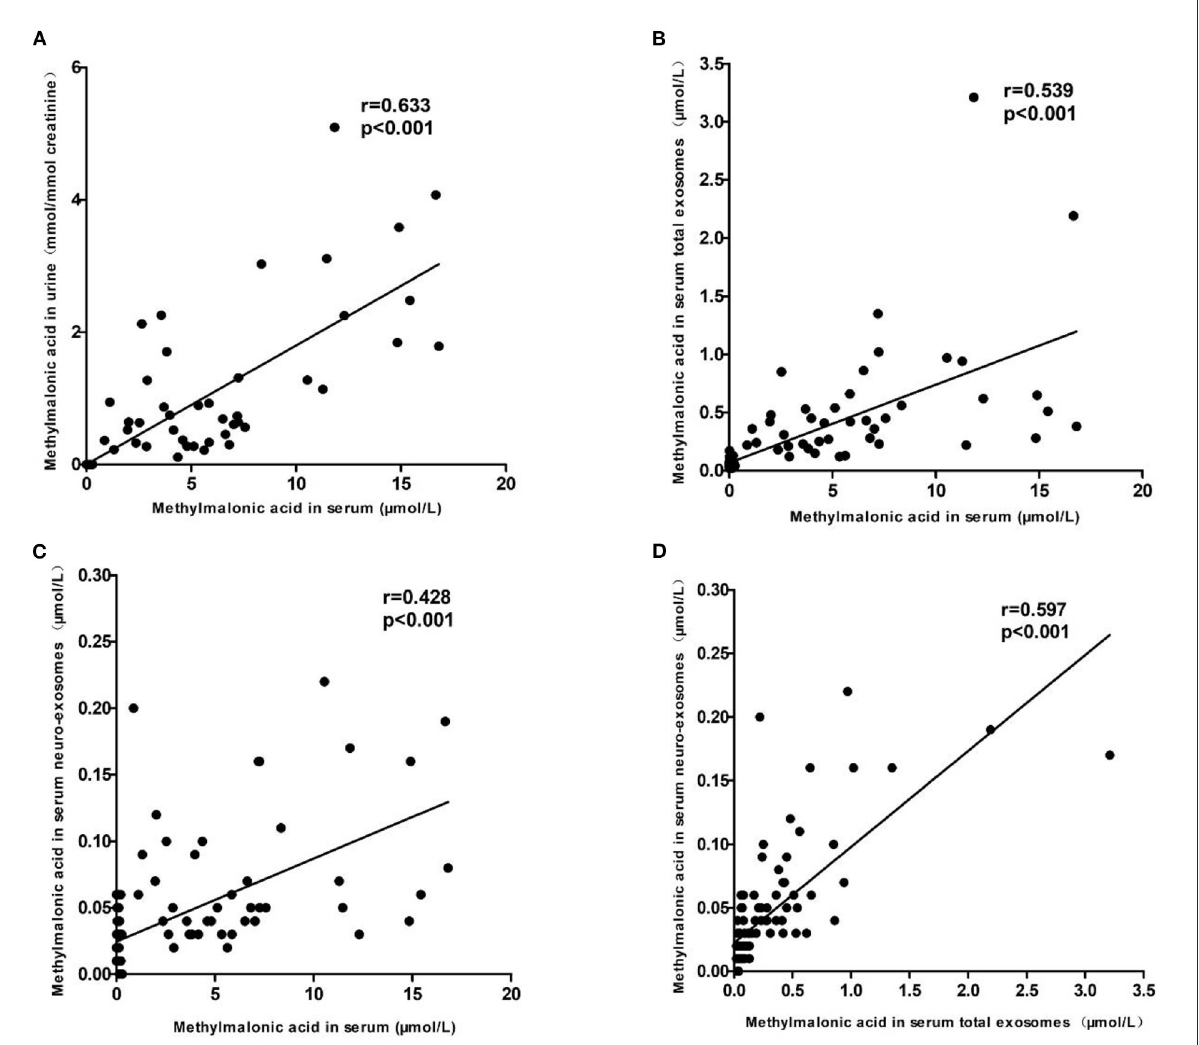
FIGURE4 The relationship among methylmalonic acid in different body fluids or exosomes. (A) Showed the correlation between methylmalonic acid in urine and in serum. (B) Showed the correlation between methylmalonic acid in serum total exosomes and methylmalonic acid in serum. (C) Showed the correlation between methylmalonic acid in serum neuro-exosomes and methylmalonic acid in serum. (D) Showed the correlation between methylmalonic acid in serum neuro-exosomes and methylmalonic acid in serum total